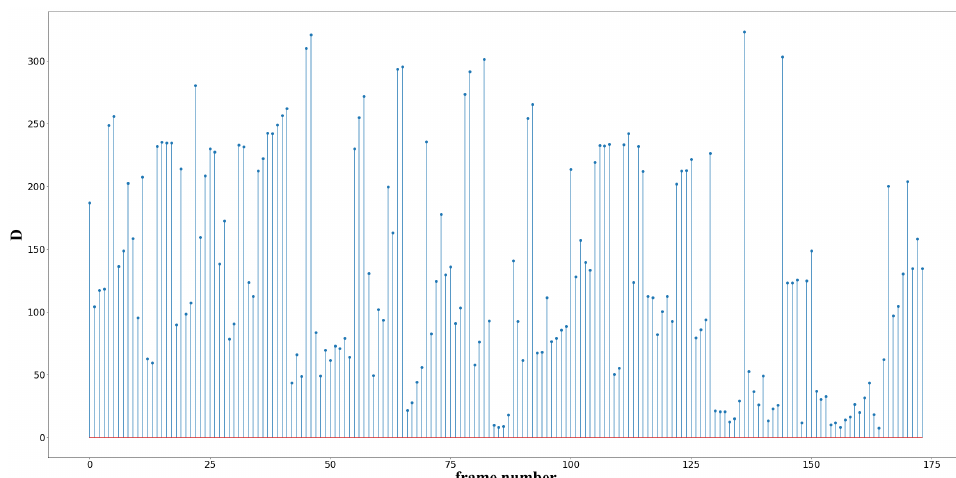
Figure 4. Interframe difference after differential frame